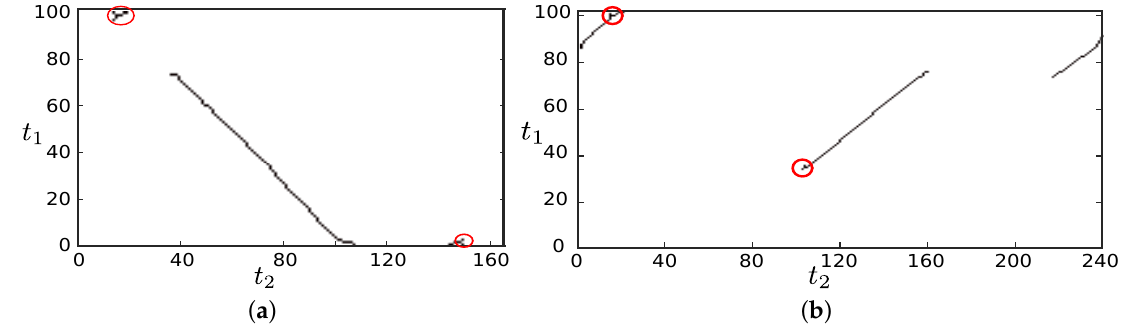
Figure 5. Examples of skeletonized distance matrix. ( a ) example 2; ( b ) example